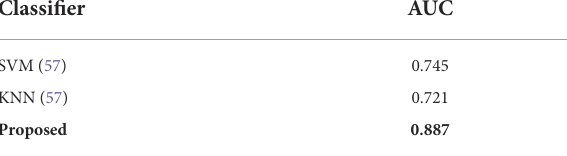
TABLE 6 Comparison with ML-based